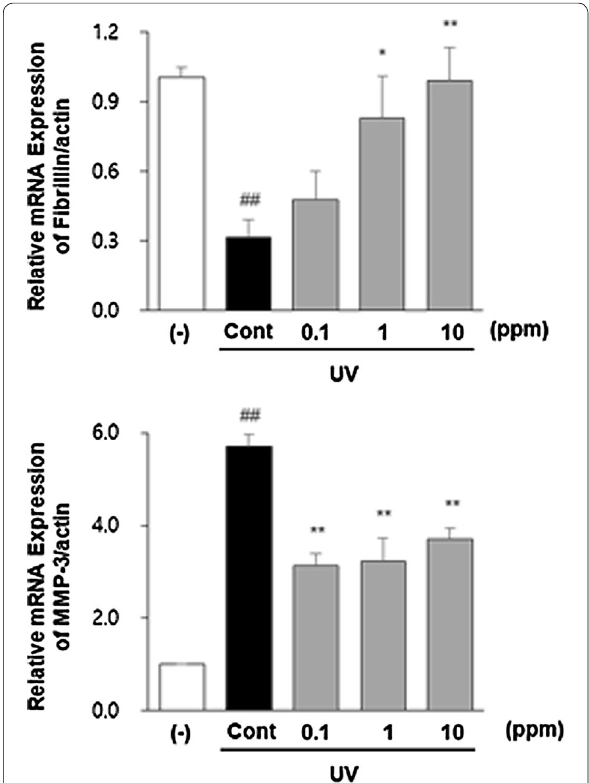
Fig. 5 Anti‑aging functions of 1,1 ′ ‑biuracil in UV‑irradiated